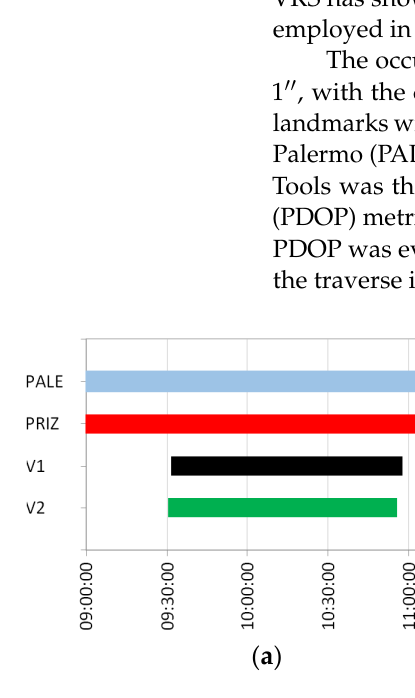
Figure 3. Time occupation planning ( a ) and network scheme ( b ), EPSG: